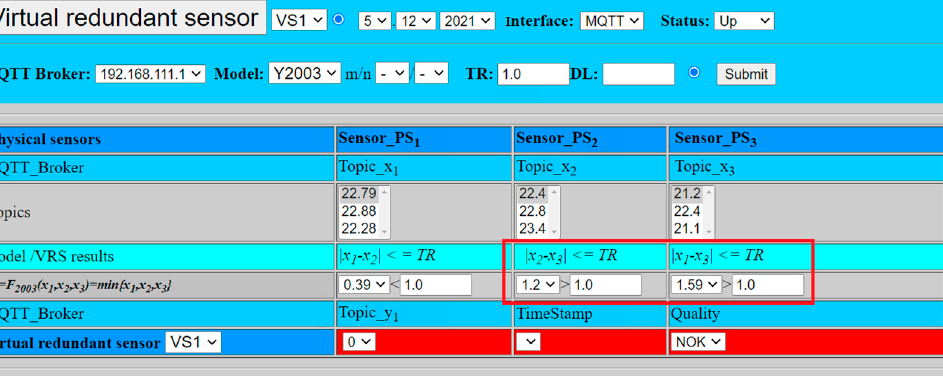
Figure 16. Virtual sensor with digital sensors and fusion function 𝐹 (cid:2870)(cid:2925)(cid:2925)(cid:2871) .